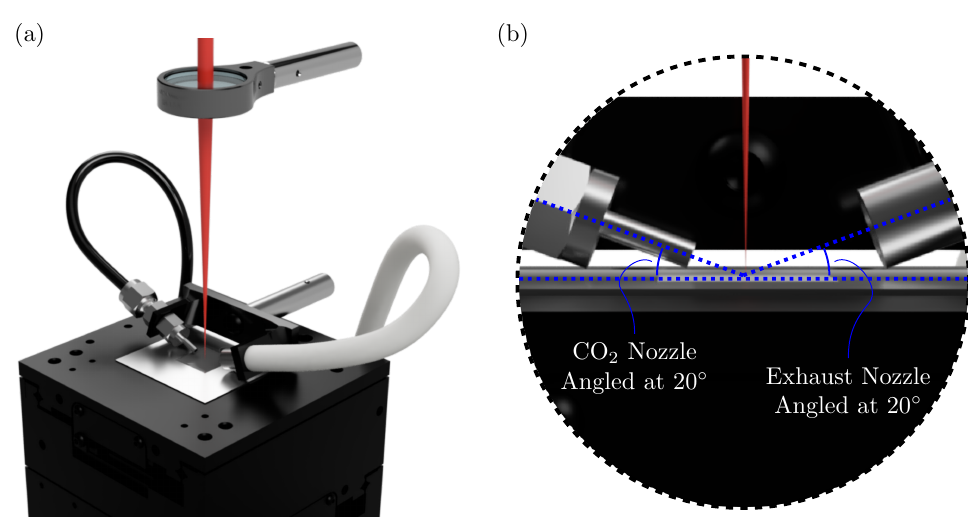
Figure 1. ( a ) Rendering of the fs-laser micromachining setup. Stainless-steel coupons are mounted hori- zontally on XY translation stages, 3 mm closer to the laser focusing lens than the focal point. A stationary nozzle is used to introduce CO 2 gas at the point of laser irradiation. ( b ) Magnified rendering of the CO 2 nozzle and exhaust line in relation to the stainless-steel substrate and laser beam